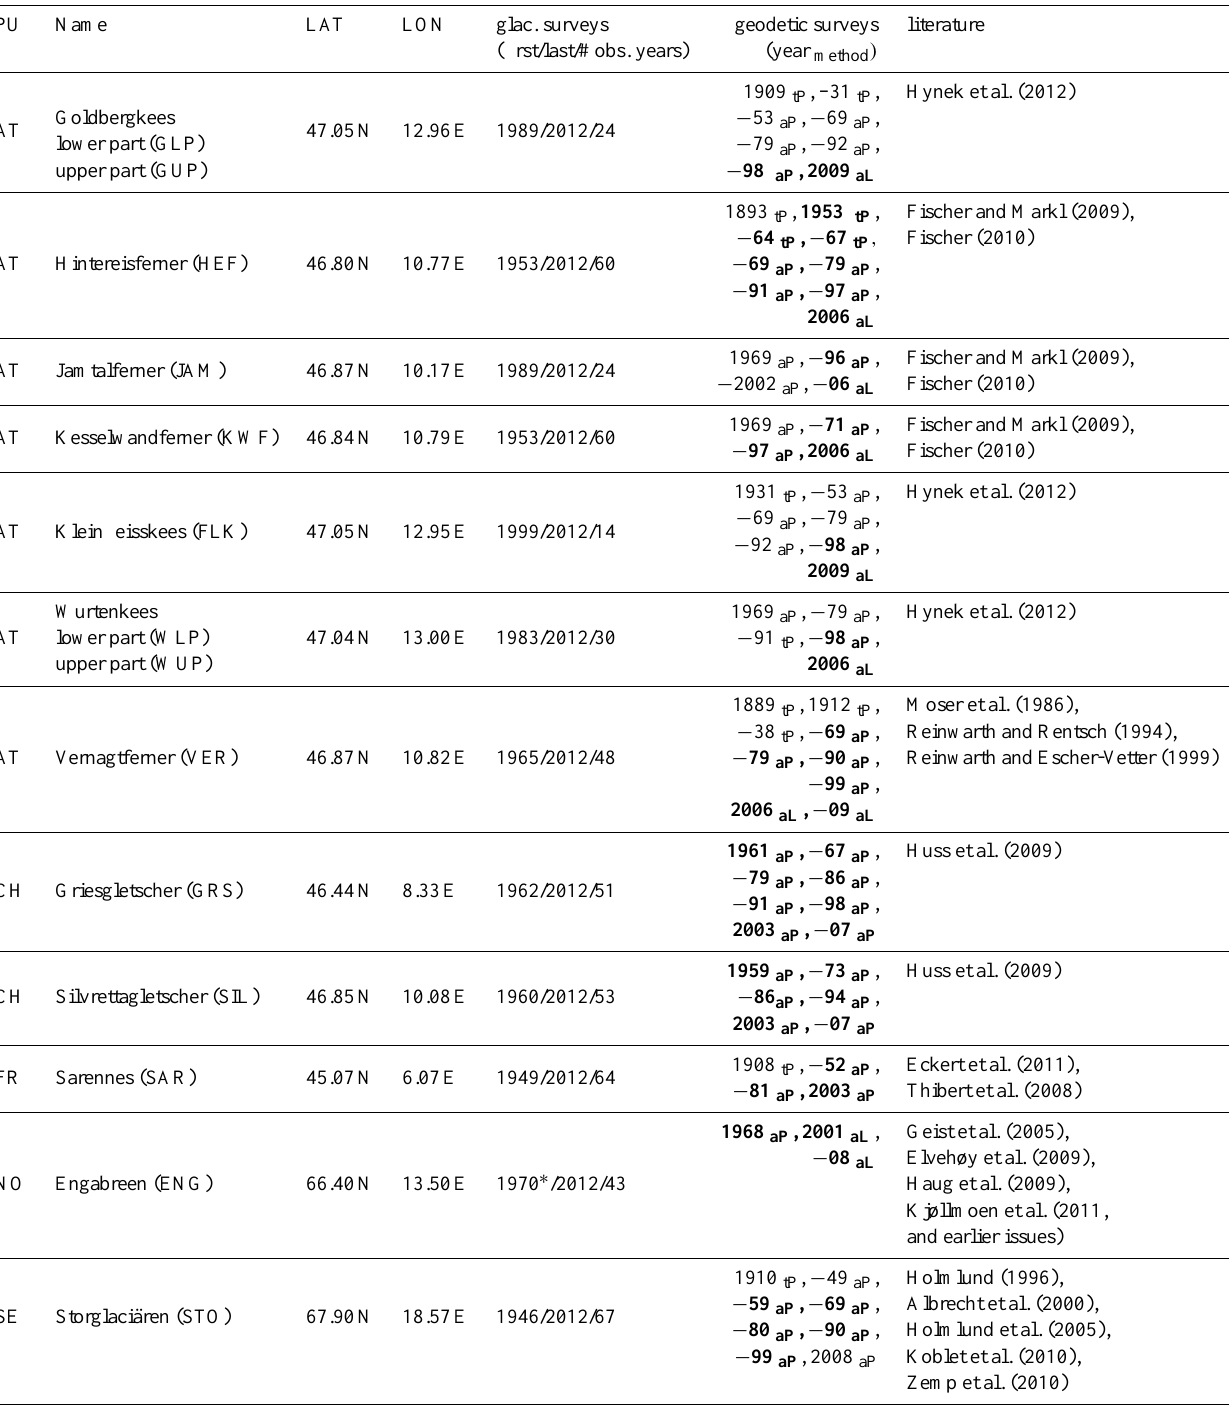
Table 1. Overview of glaciers used in this study with information about glaciological and geodetic surveys. Analysed periods of record are indicated by highlighting years of corresponding geodetic survey in bold. Methods are abbreviated as follows: t = terrestrial, a = airborne, T = tachymetry, P = photogrammetry, L = laser